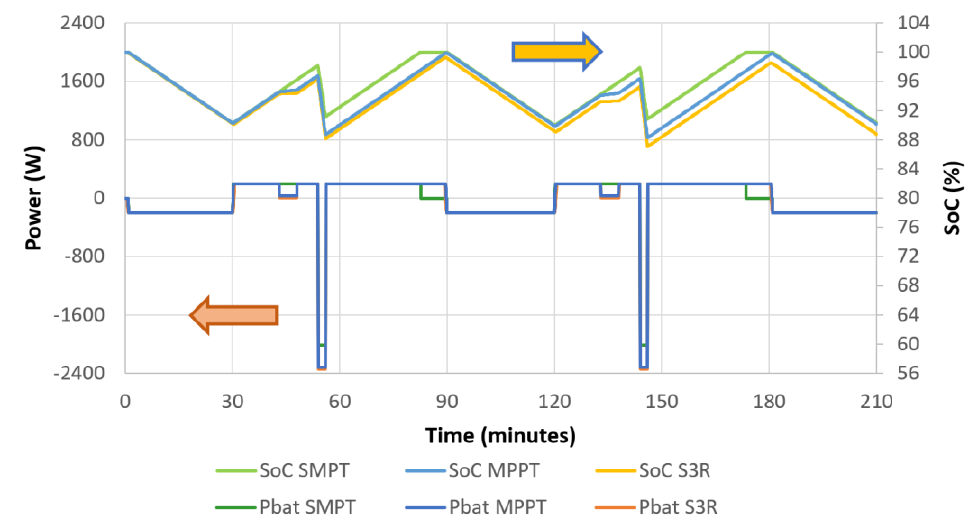
Figure 9. Battery State of Charge (upper curves, right axis) and Charging Power for battery (lower curves, left axis).